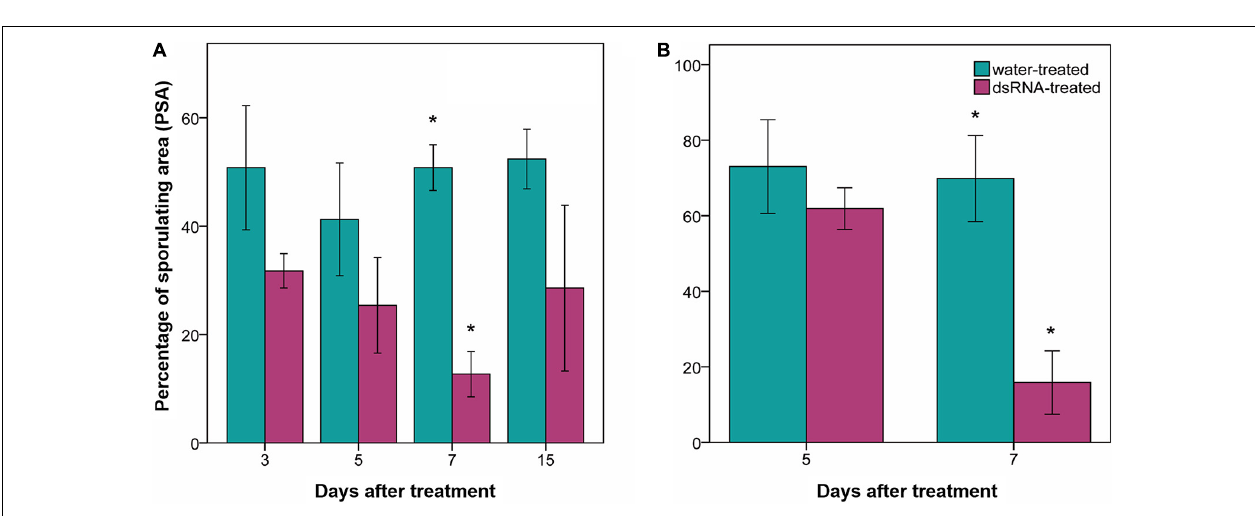
FIGURE 3 | Effect of dsRNA treatment on percentage of sporulating area (PSA) evaluated 7 days after Plasmopara viticola inoculation. PSA evaluated on Pinot noir plants grafted onto SO4 at 3, 5, 7, and 15 days after treatment (dat) (A) , and on self-rooted Pinot noir plants at 5 and 7 dat (B) . Bars represent standard error. Asterisks indicate statistically significant differences among the dsRNA- and water-treated conditions at each time point (* p value <